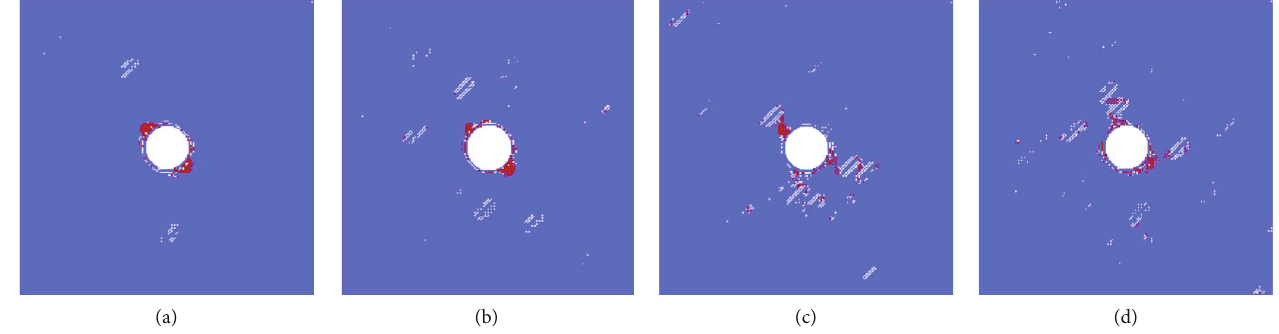
Figure 9: Excavation damage range under di ff erent fi ssure numbers. (a) N = 10 . (b) N = 20 . (c) N = 30 . (d) N = 40 .